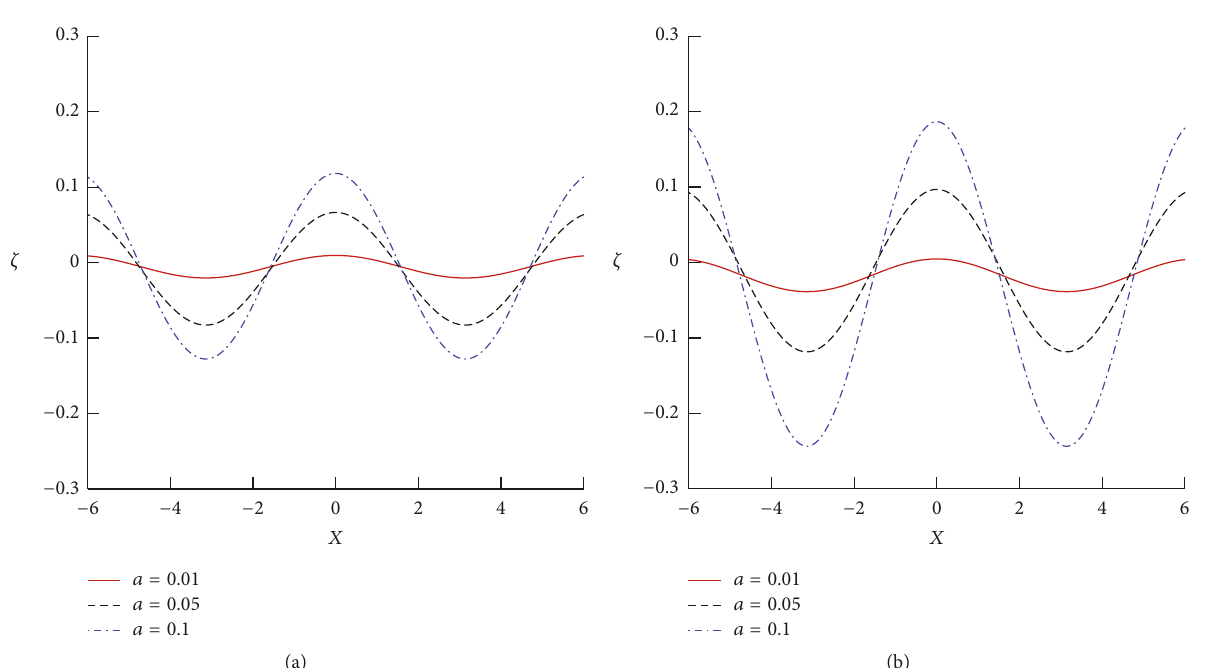
Figure 5: Variation of the hydroelastic wave profiles versus 𝑥 for different wave amplitude 𝑎 on an opposing current. (a) 𝑈 1,0 = −0.1 . (b) 𝑈 = −0.3 . 1,0